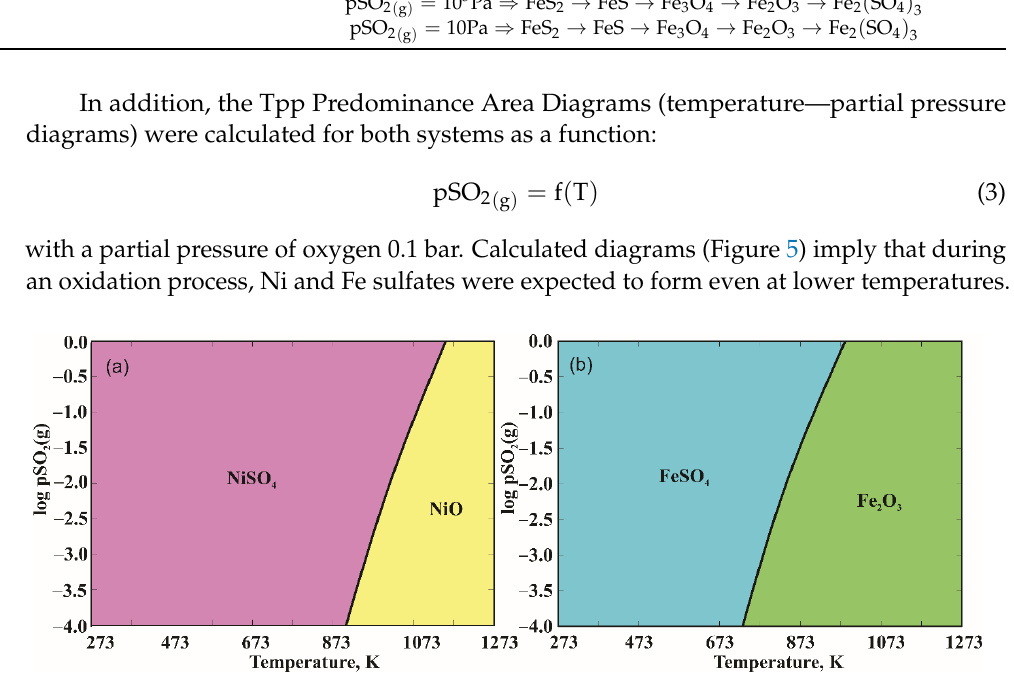
Figure 5. Tpp Predominance Area Diagrams for ( a ) Ni ‐ S ‐ O and ( b ) Fe ‐ S ‐ O system for a constant value of oxygen partial pressure [37]. Based on the theoretical calculations, reactions in the given systems were proposed and changes in Gibbs free energy were calculated. Thermodynamically possible reactions for both systems are given in Table 4. Table 4. Values of change in Gibbs free energy calculated for theoretically proposed reactions for Ni ‐ S ‐ O and Fe ‐ S ‐ O systems [37]. Reaction